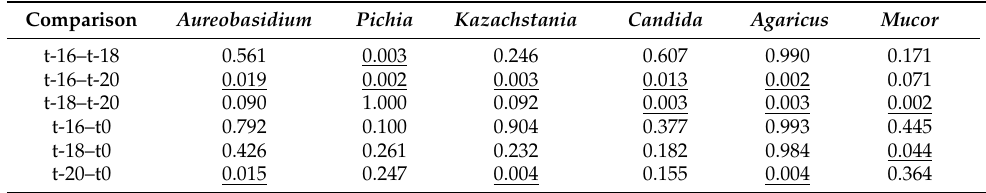
Table 3. Genera that are significantly different over time during the adaptation period. p ‐ values of Dunn’s test for different genera; significant p ‐ values underlined.